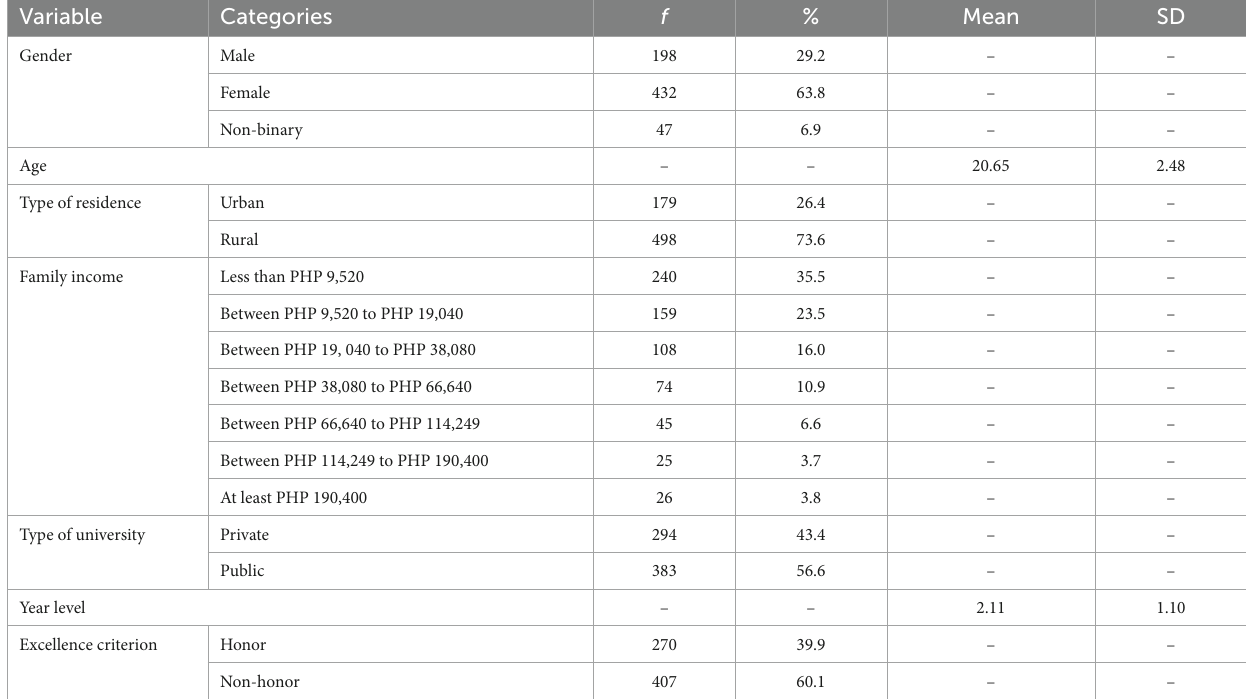
TABLE 1 Profile of respondents, n =